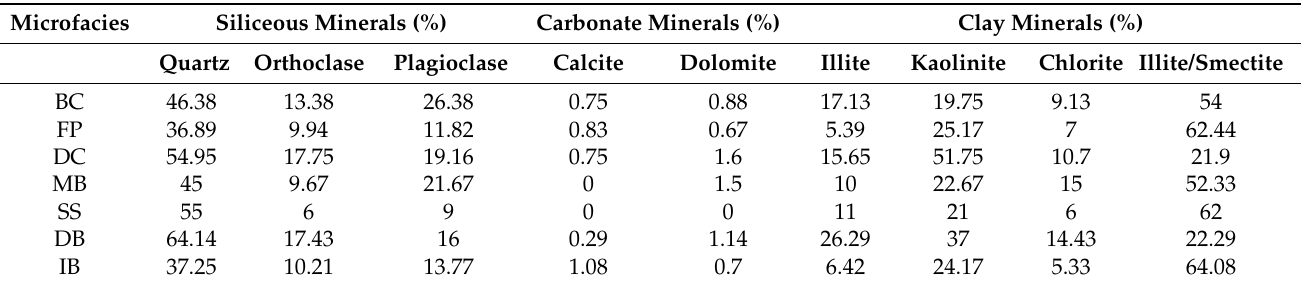
Table 5. Mineral content of different sedimentary